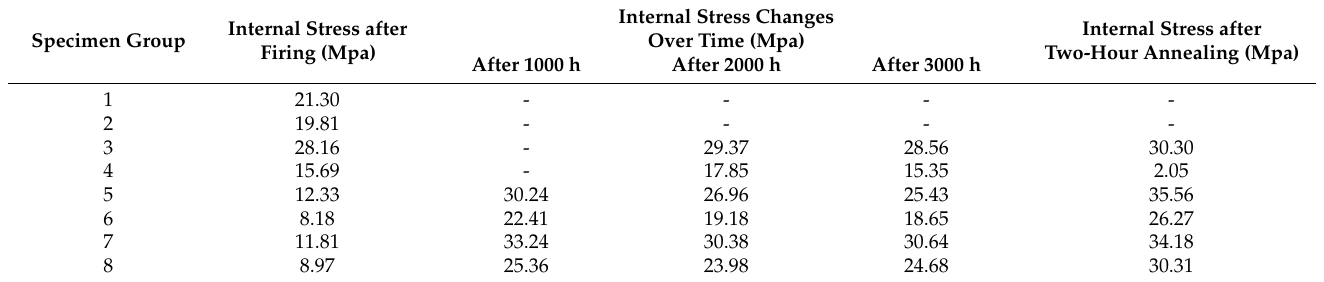
Figure 6. Calculated internal stress for all specimen groups. Table 2. Results of internal stress measurement.